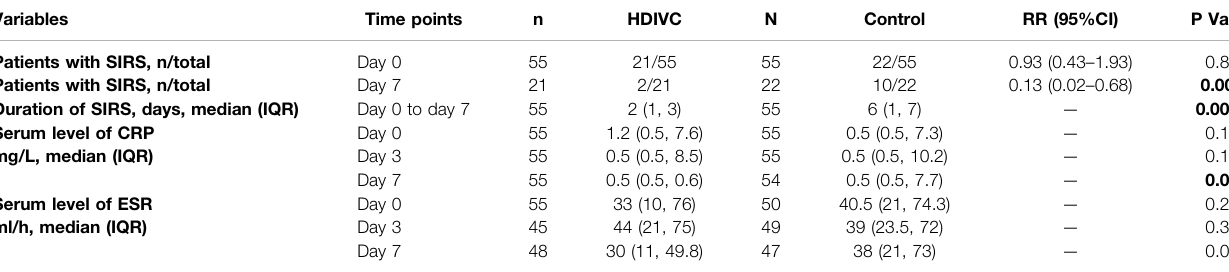
TABLE 2 | Effect of HDIVC on in fl ammatory response. Variables